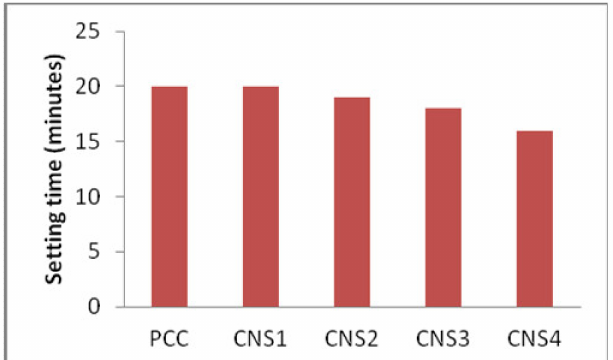
Figure 4. Analysis of Napa soil usage to the setting time (minutes) with its variation.